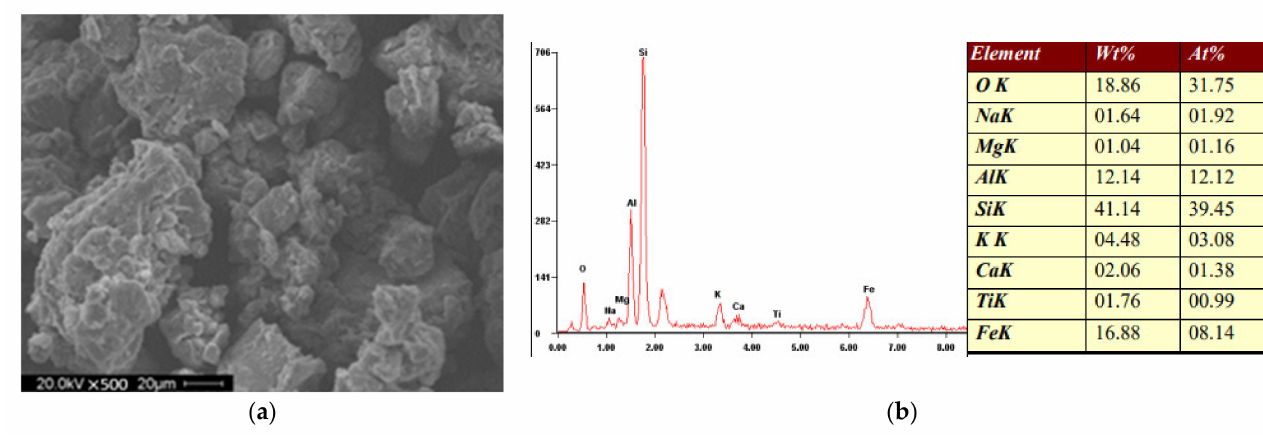
Figure 6. Result of ( a ) SEM, ( b ) EDX.